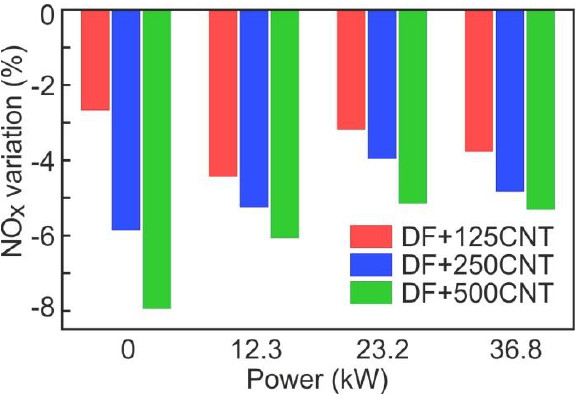
Figure 12. Change in nitrogen oxides ( C NO addition at different diesel engine loads. Energies 2019 , 12 , x FOR PEER REVIEW